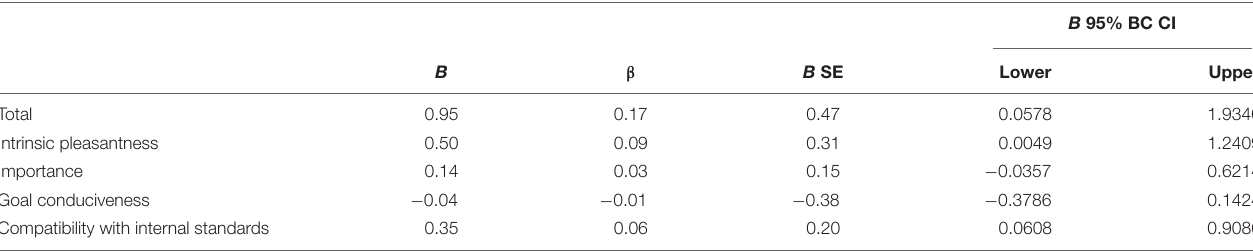
FIGURE 1 | Mediation model of affiliative extraversion and warmth-affection through appraisals. All coefficients represent unstandardized (standardized) regression coefficients, controlling for Assertiveness and baseline warmth-affection scores. Bold lines represent significant coefficients, p < 0.05. TABLE 4 | Unstandardized (B) and standardized ( β ) coefficients, standard errors and bias-corrected confidence intervals of the mediation model testing the indirect effects of the affiliative extraversion on warmth-affection through appraisals following the family